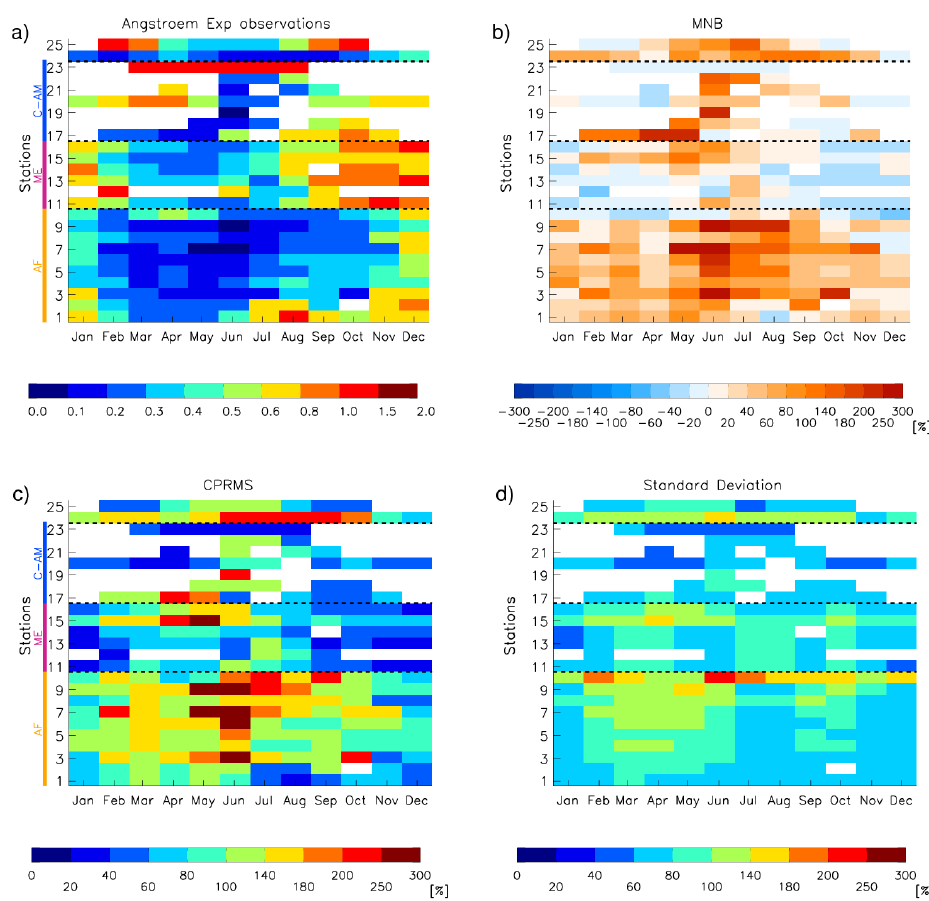
Fig. 13. Same as Fig. 10 but for Angstr¨om exponent. For the individual figure of each model presenting the simulated values and their differences (in %) with respect to observations see Figs. S12 and S13, respectively, in the